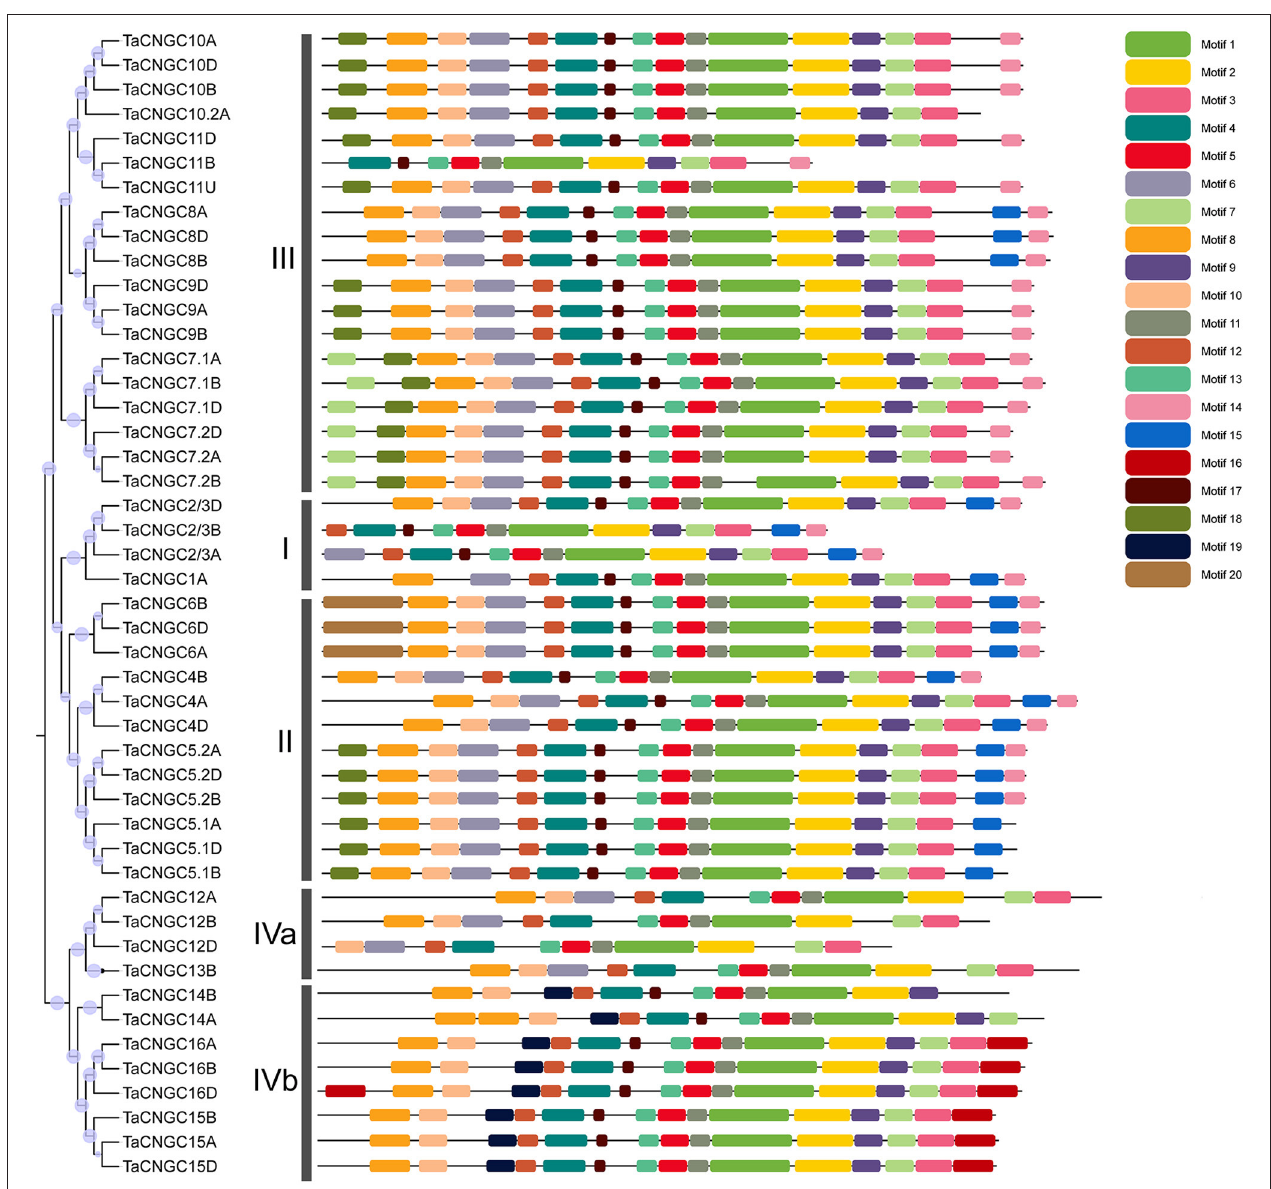
FIGURE 1 | Phylogenetic analysis and conserved motifs in wheat CNGC proteins. The tree was created with bootstrap of 1000 by maximum likelihood (ML) method in MEGA6. The TaCNGCs were divided into four groups with the two sub-group of IVa and Ivb. Model exhibition of motifs composition in TaCNGC amino acid sequences using